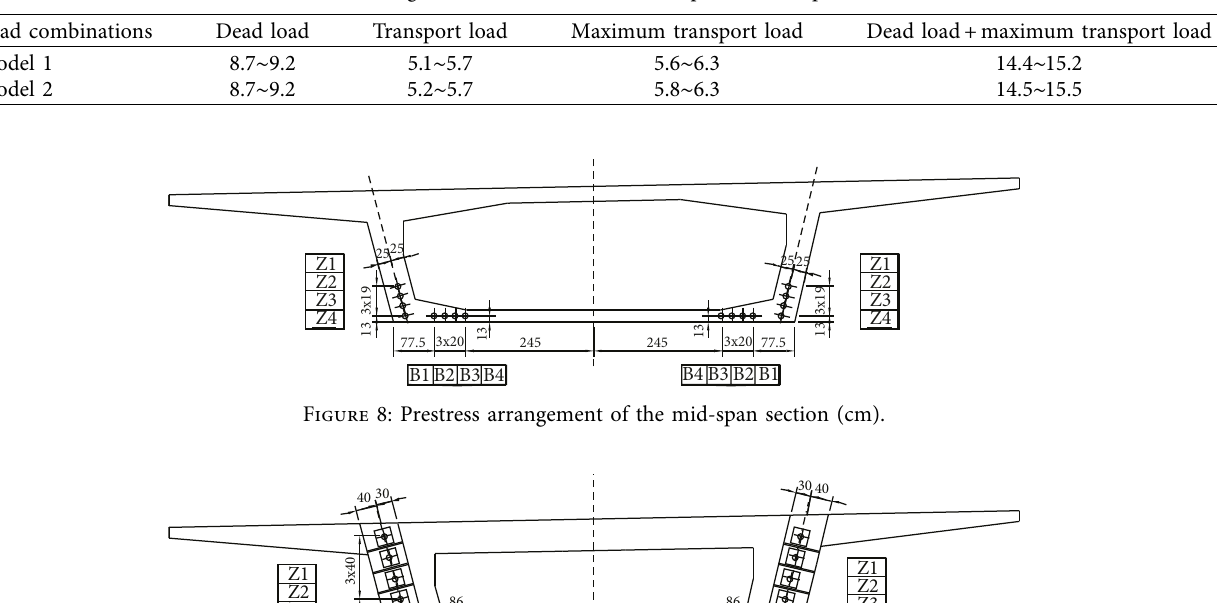
Figure 7: Longitudinal stress increment of mid-span section caused by transport load (Pa). Table 2: The lower edge stress increment of bottom plate in midspan section (MPa).